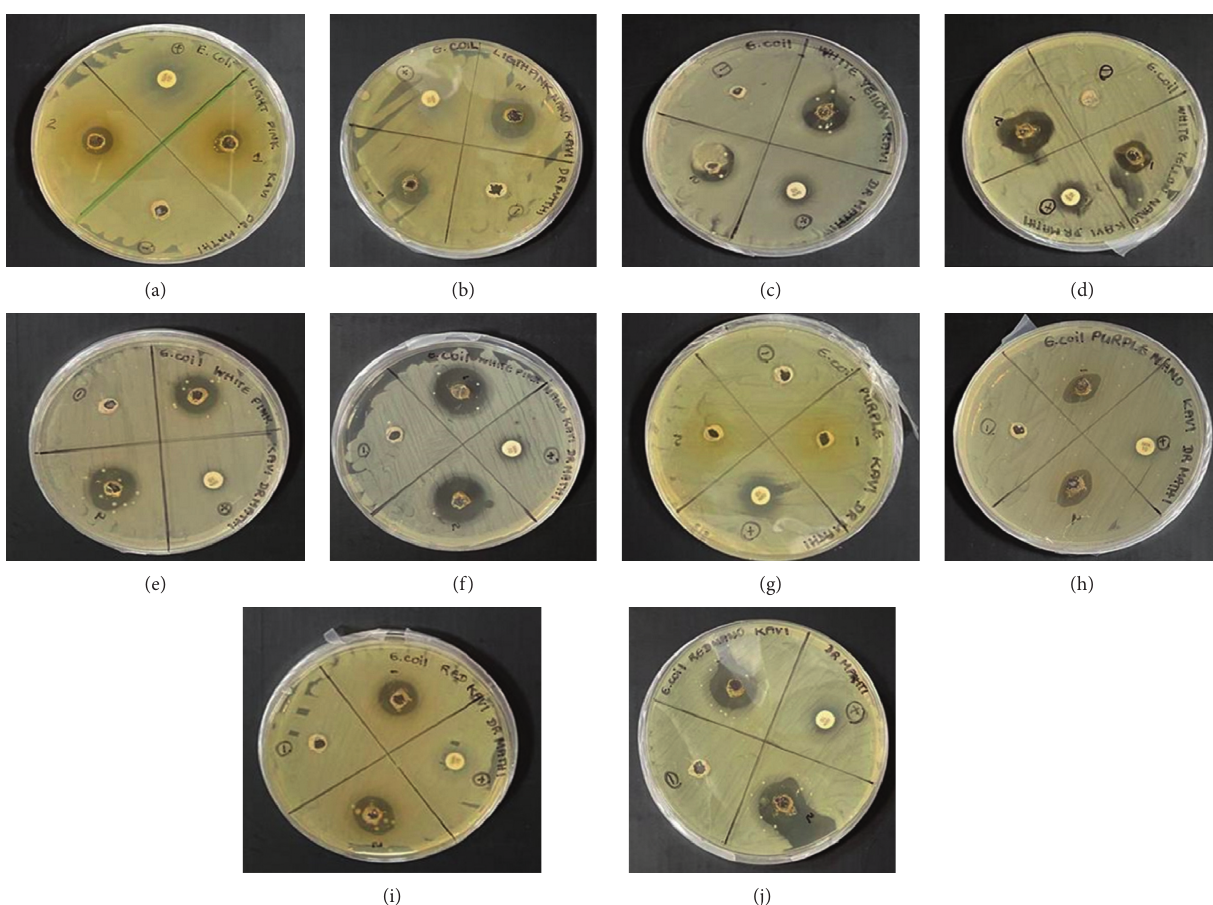
Figure 21: Antimicrobial activity of synthesized AgNPs and their respective flower extracts against Escherichia coli . (a) Light pink flower extract. (b) Light pink AgNPs. (c) White yellow flower extract. (d) White yellow AgNPs. (e) White pink flower extract. (f) White pink AgNPs. (g) Purple flower extract. (h) Purple AgNPs. (i) Red flower extract. (j) Red AgNPs.